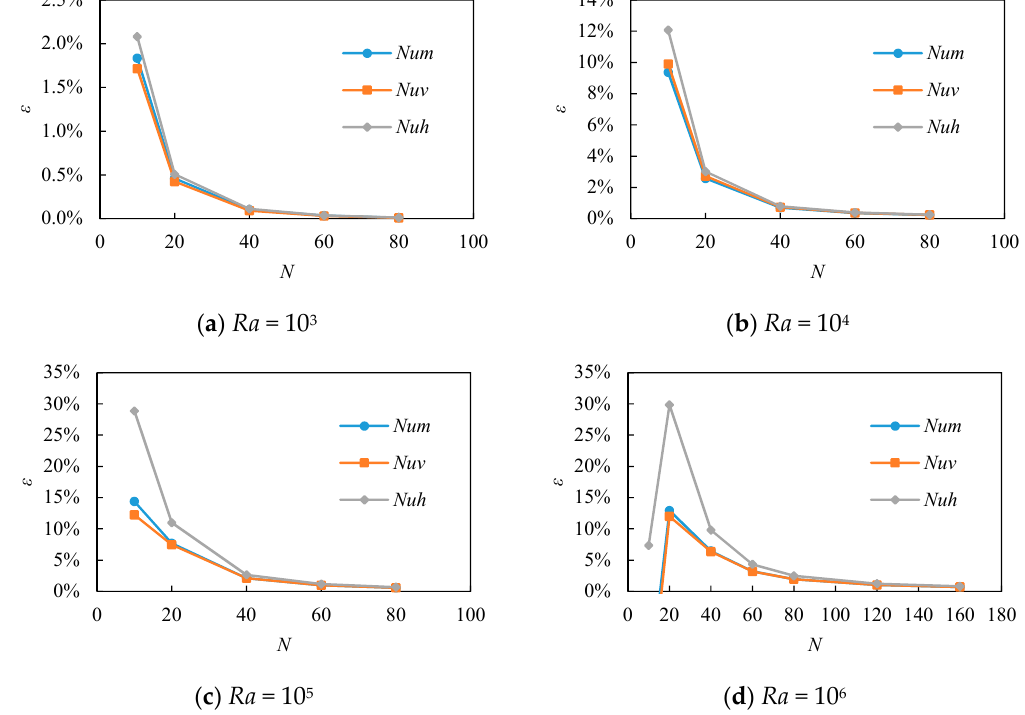
Figure 3. Dependence of the error, ε , to the grid number, N at Pr = 0.71.